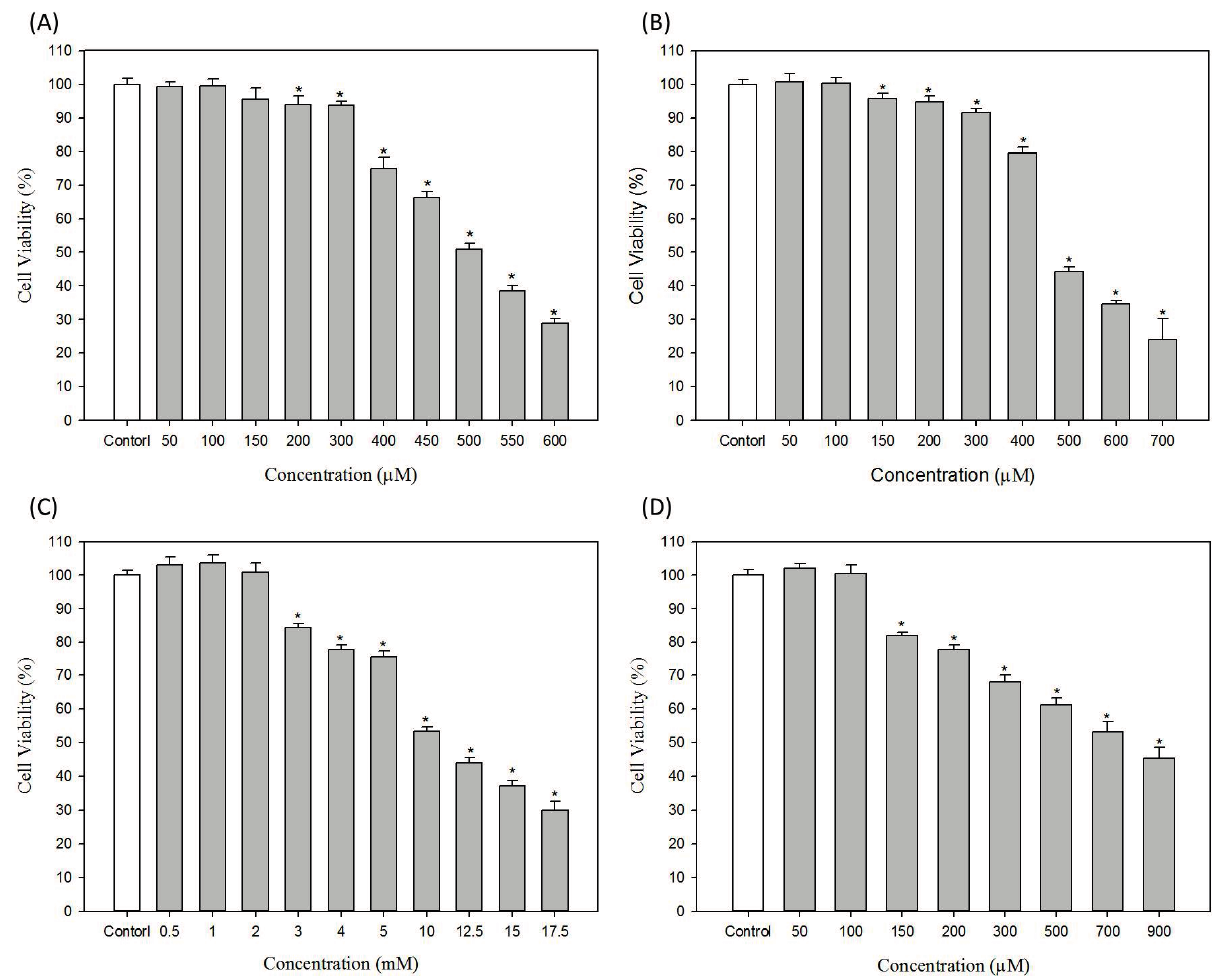
Figure 2. Effects of hair dyes on the cell viability of B16-F10 cells. ( A ) Ammonium persulfate; ( B ) Sodium persulfate; ( C ) Resorcinol and ( D ) Lawsone. Each value is expressed as the mean ± S.E. ( n = 6), * p < 0.05 compared with the